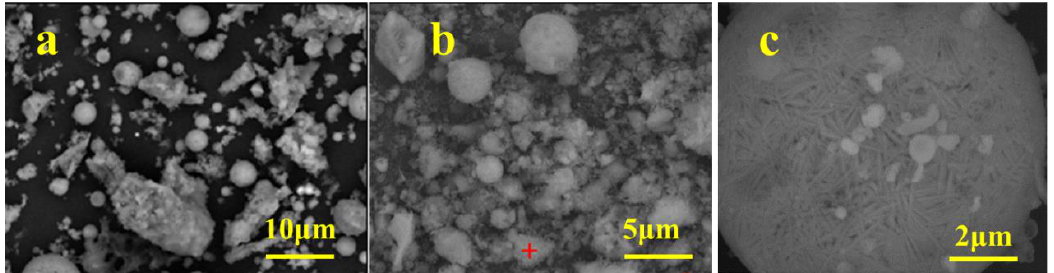
Figure 5. Morphologies of HAFA ( a ), AHAFA ( b ) and DHAFA ( c ).